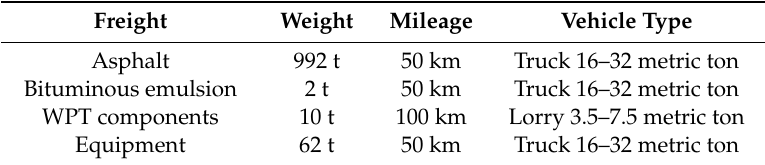
Table 5. Transport of the materials and equipment to and from the construction